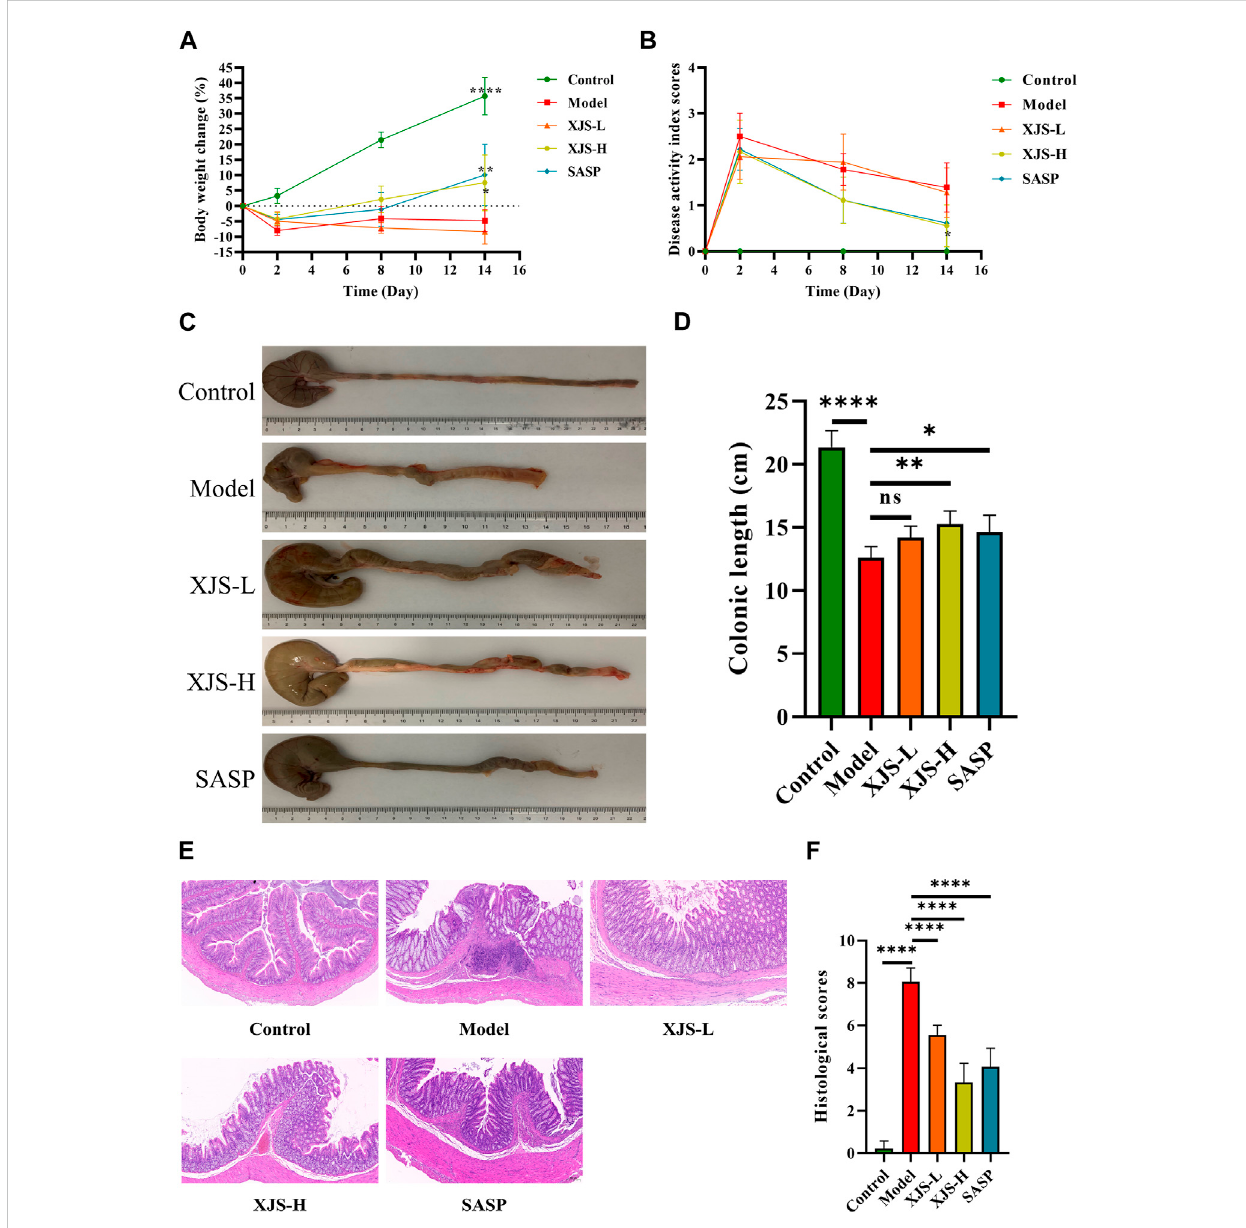
FIGURE 2 XJSalleviatedTNBS-inducedcolitis. (A) Thebodyweightchangesonday2,day8andday14( n =6). (B) TheDAIscoresrecordedonday0,day2,day 8 and day 14 ( n = 6). (C, D) Colon length ( n = 6). (E) Representative pictures of HE staining ( n = 6). (F) Histological scores ( n = 6). * p < 0.05, ** p < 0.01, **** p < 0.0001, ns = no signi fi